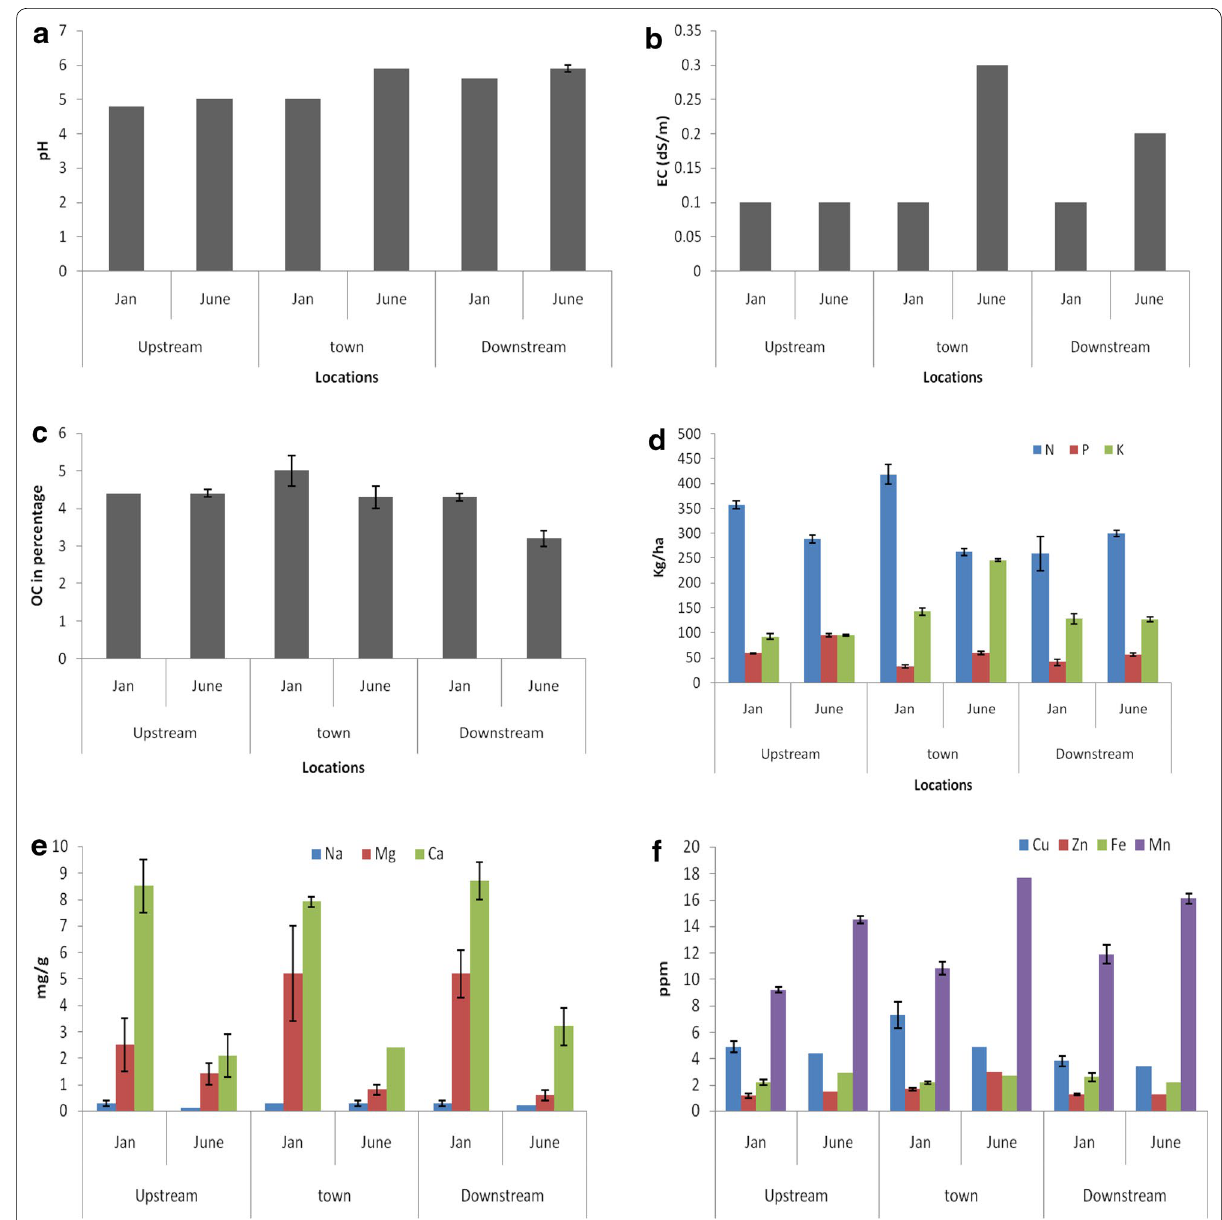
Fig. 2 Soil characteristics in floodplain agriculture field along the Munawar Tawi from upstream, town and downstream locations in January and June 2014 ( a – c shows pH, EC, OC respectively; d shows N, P and K; e shows alkaline elements Na, K and Ca; f shows